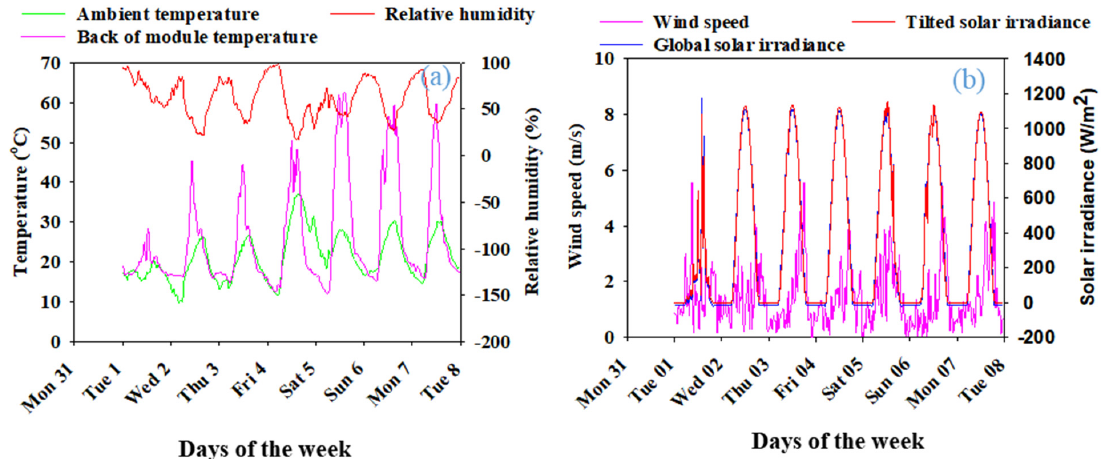
Figure 11. A week of ambient weather conditions of ( a ) temperature and relative humidity ( b ) wind speed and solar irradiance against days of the week at SolarWatt Park.